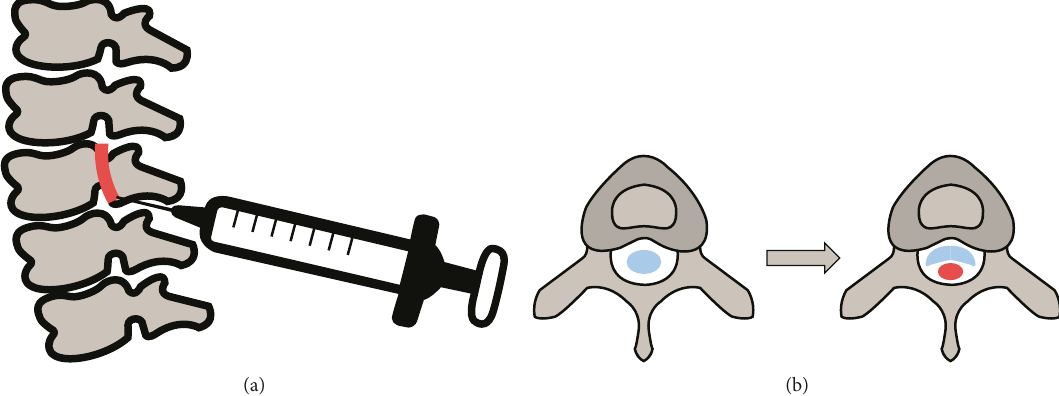
Figure 1: Schemes of LSS-induced surgery in (a) sagittal and (b) transverse planes. A piece of silicone (red) was inserted by a syringe to narrow the spinal canal (white), and the spinal cord was pressurized